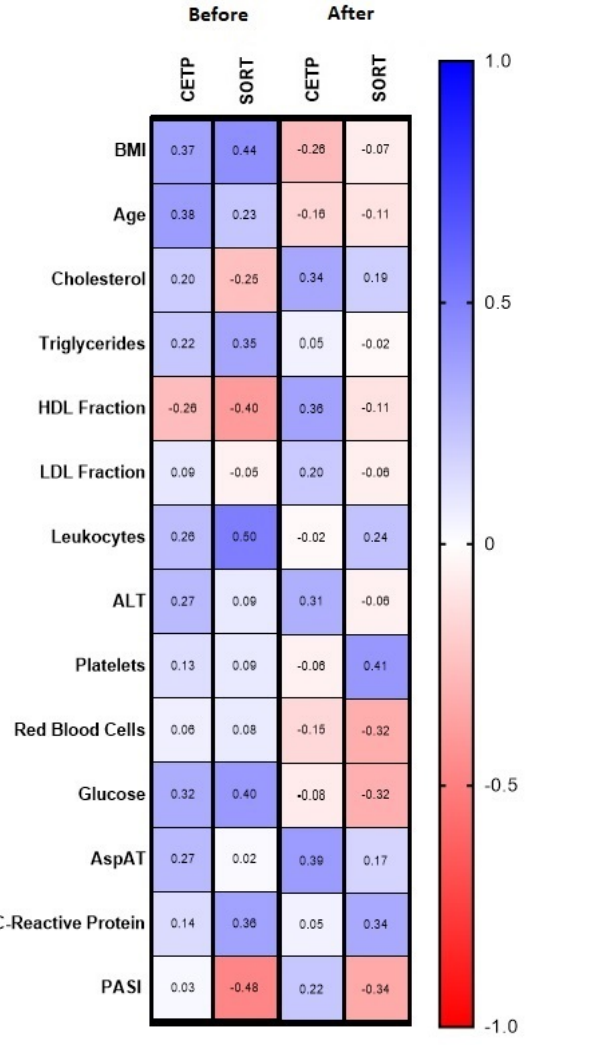
Figure 2. Associations between CETP, SORT, PASI and laboratory parameters before and after the treatment.